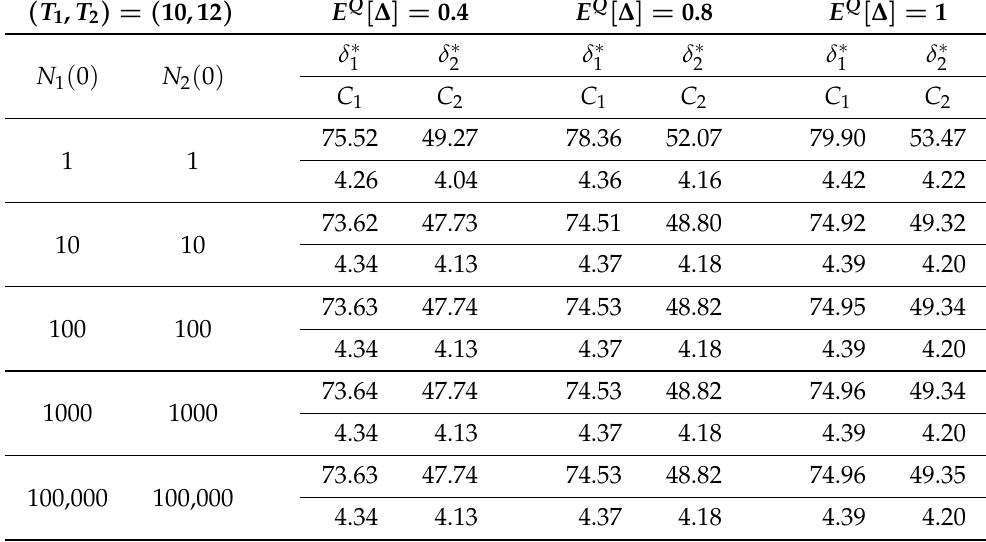
Table 5. Fair participation rates and certainty equivalent returns for Case 2 with ( T 1 , T 2 ) = ( 10,12 ) , different portfolio sizes with N 1 ( 0 ) = N 2 ( 0 ) and different values of E Q [ ∆ ] . All results are in